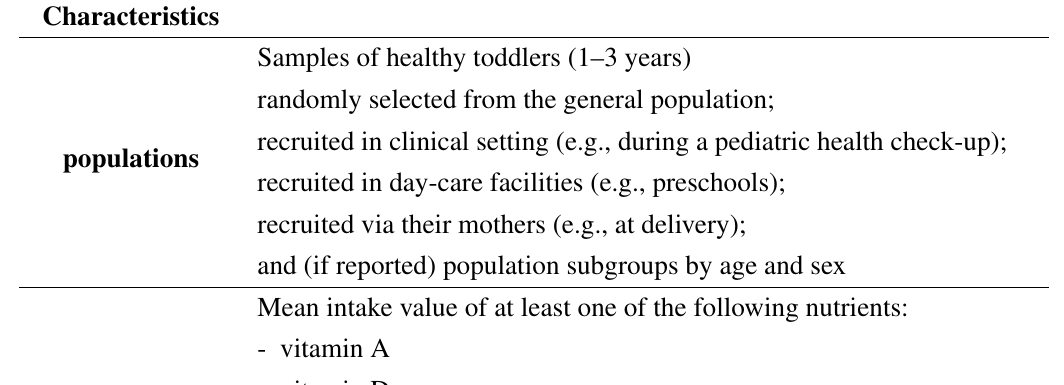
Table 1. Inclusion criteria for studies eligible for the